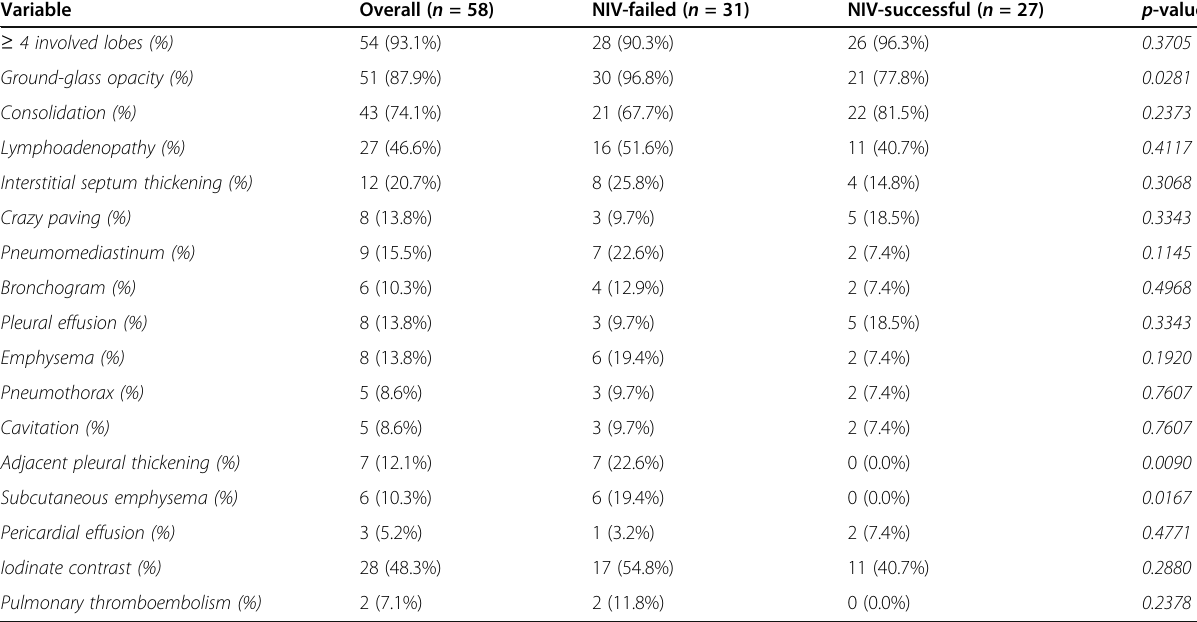
Table 4 NIV-failed and NIV-successful groups: chest CT scan feature statistical analysis Variable Overall ( n =